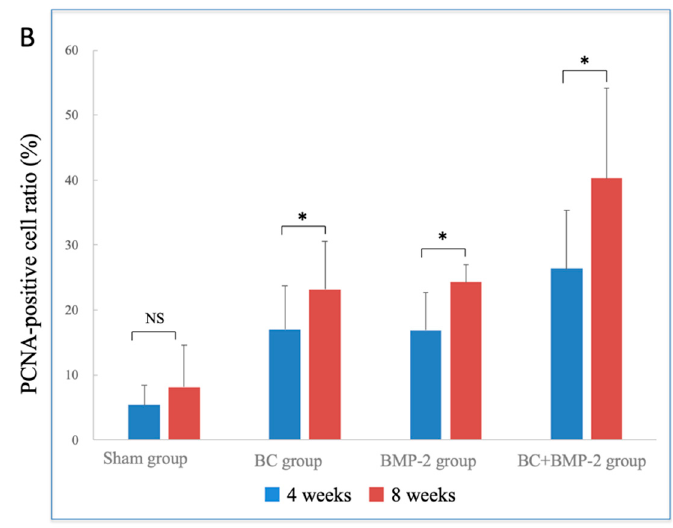
Figure 6. Immunohistochemical staining analysis of PCNA-positive cell ratios: ( A ) Comparison of the PCNA-positive cell ratios between groups, analyzed by one-way analysis of variance and LSD- t test. * p < 0.05; NS: no significance. Error bars indicate standard deviations. ( B ) Comparison of PCNA-positive cell ratios between time points, analyzed by independent-samples t -test. * p < 0.05; NS: no significance. Error bars indicate standard deviations.